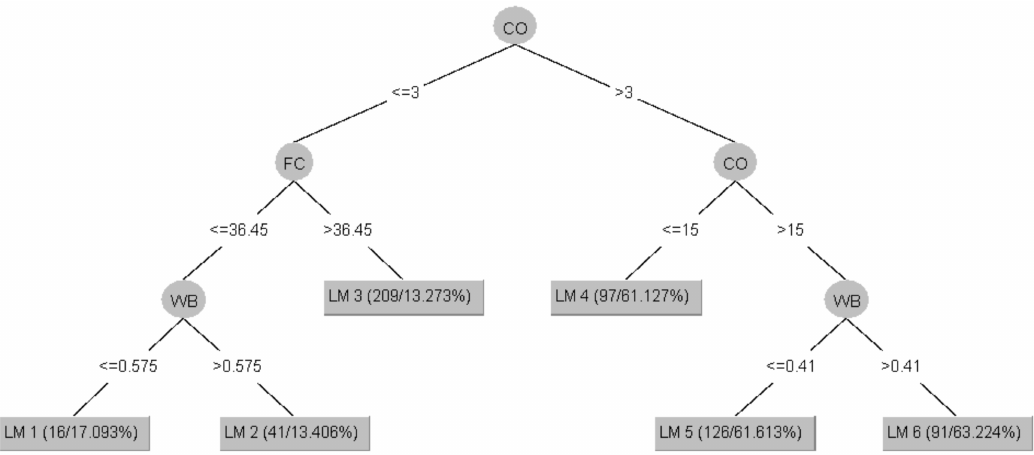
Figure 4. Model for MT